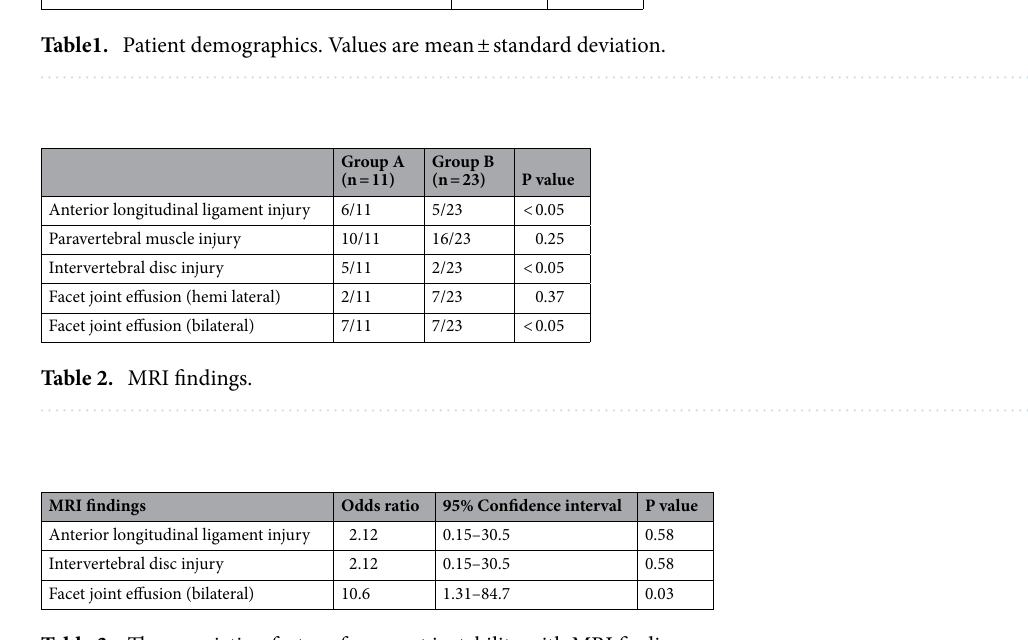
Table 3. The association factor of segment instability with MRI